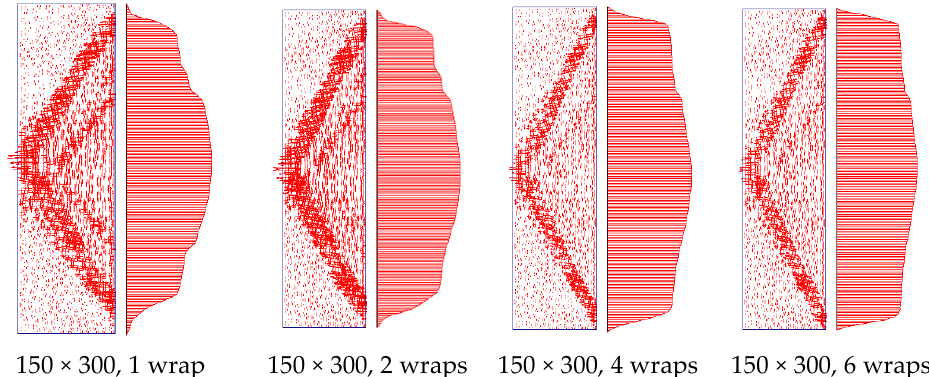
Figure 6. Half cross-section of the 150 mm × 300 mm cylinder with localized failure and the FRP wrap hoop strain profile at peak FRP strain = 1.5%.